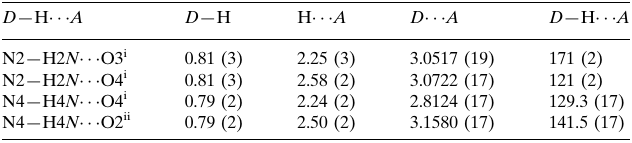
Hydrogen-bond geometry (A˚ , (cid:1)